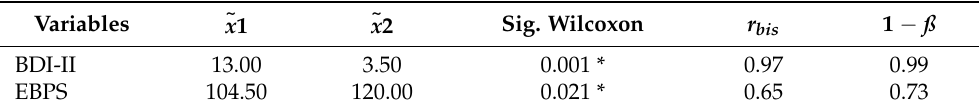
Table 6. Wilcoxon test applied to subjective psychological well-being and depression levels assessed in ePSICONUT.